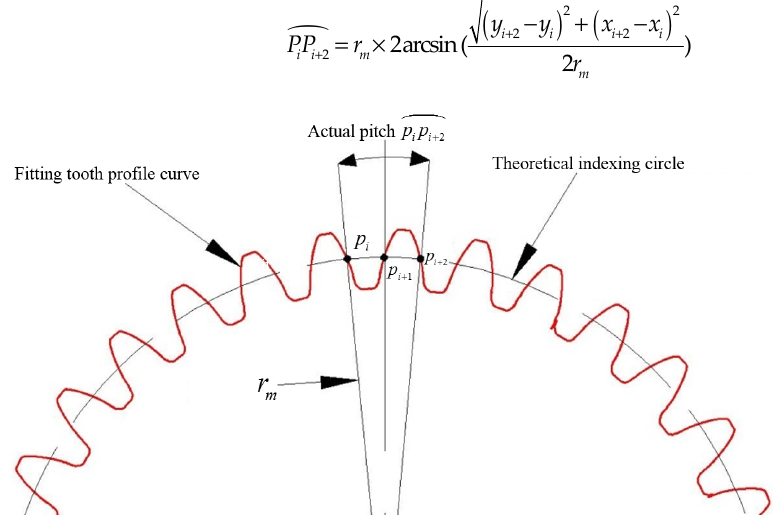
Figure 5. Schematic diagram of the pitch deviation calculation.